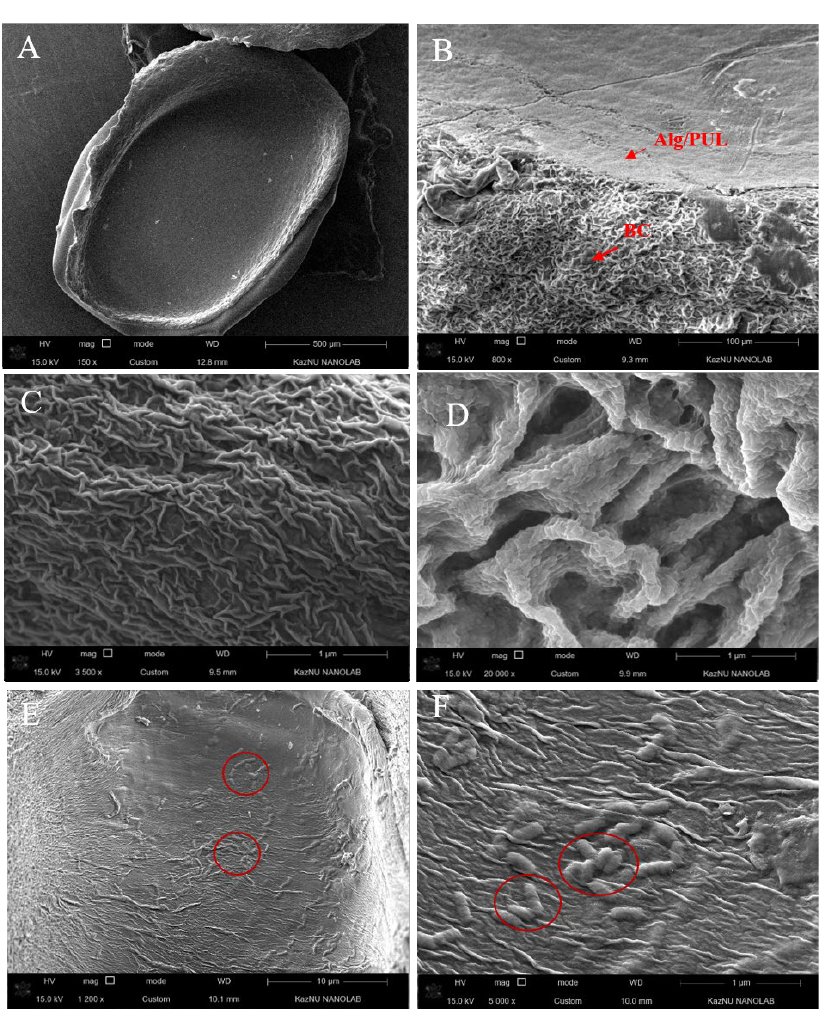
Figure 3. SEM images of Alg-PUL/BC beads: in cross section ( A ), in the shell section ( B ), bead shell ( C ), BC pores on the shell ( D ), LGG cells inside the bead ( E , F ). The cellulose shell is also clearly visible. Moreover, it looks folded and dense and has a multi-layered structure covering the core. The formation of such a dense shell is associ- ated with a unique three-dimensional BC network. The pore size is in a range that is in- sufficient for the release of encapsulated probiotics into the environment. Therefore, such a shell should be a strong framework to protect probiotics when passing through the di- gestive system. An experiment confirming this is presented in the next section.